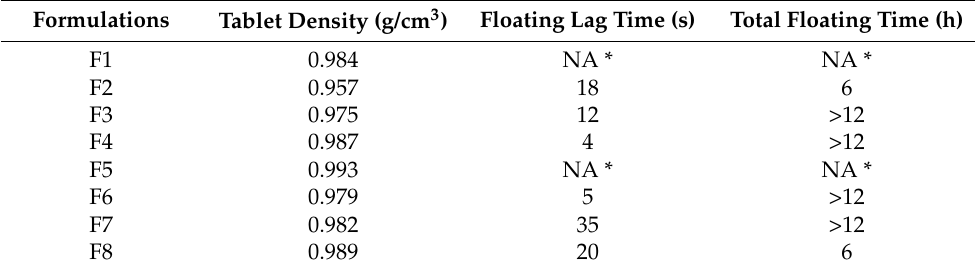
Table 6. Floating behavior of metronidazole effervescent floating